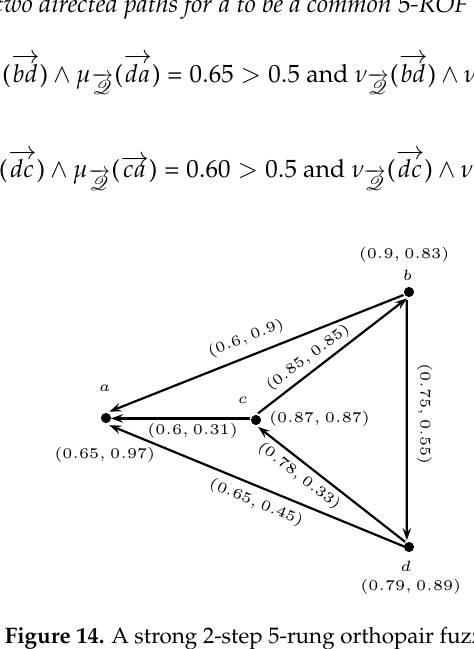
Figure 14. A strong 2-step 5-rung orthopair fuzzy